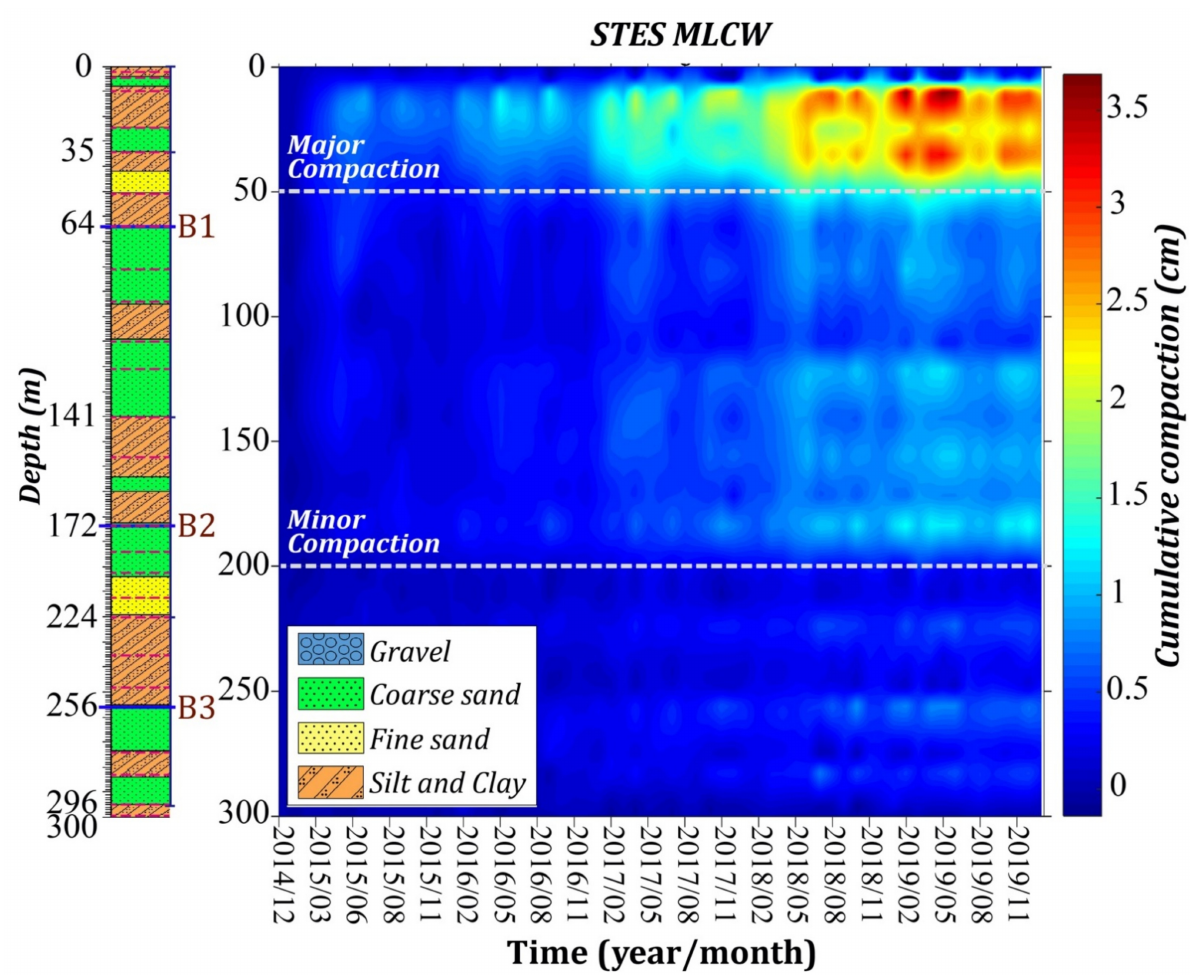
Figure 8. A time-depth diagram of compaction at a series of magnetic rings at the MLCW station STES from December 2014 to December 2019. The cold color indicates relative swelling and the warm color indicates compaction. Since 2017, shallow-depth compactions (at depths < 50 m) increased significantly (the region with warm